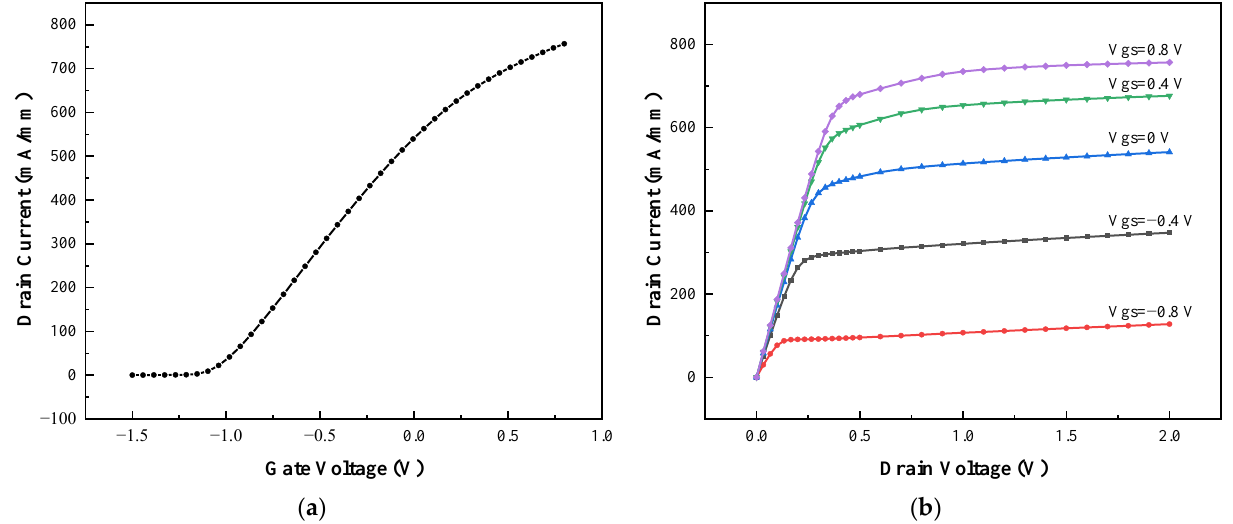
Figure 2. DC characteristic of pHEMT: ( a ) opening characteristic curve; ( b ) transfer characteristic curve.